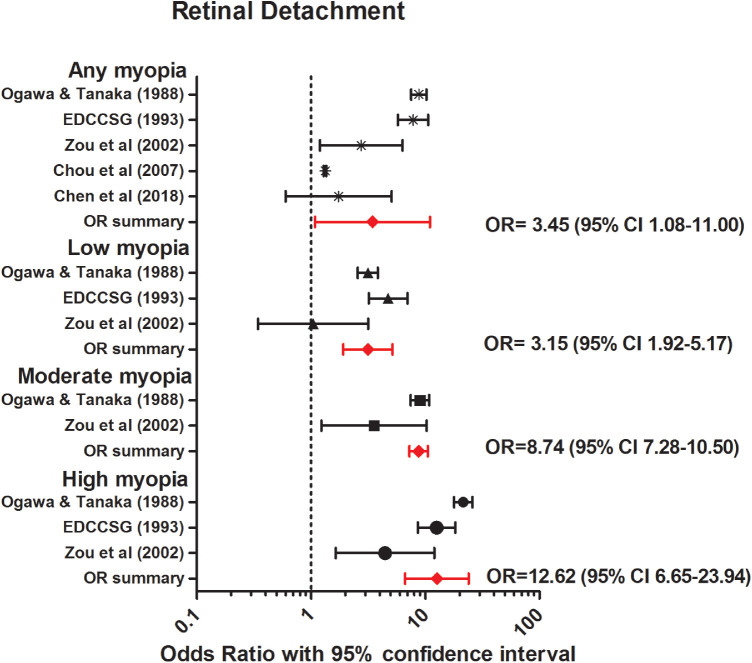
Forest plot of RD in any myopia (random effects model; Q = 1.7; I2 = 0.0); low myopia (random effects model; Q = 3.7; I2 = 0.5); moderate myopia (fixed effects model; Q = 2.8; I2 = 0.6); and high myopia (random effects model; Q = 3.3; I2 = 0.4). Red lines with diamond represents the summary OR per myopia category. Summary OR for myopia categories are as follows: any myopia OR, 3.45 (95% CI, 1.08–11.00); low myopia OR, 3.15 (95% CI, 1.92–5.17); moderate myopia OR, 8.74 (95% CI, 7.28–10.50); and high myopia OR, 12.62 (95% CI, 6.65–23.94).